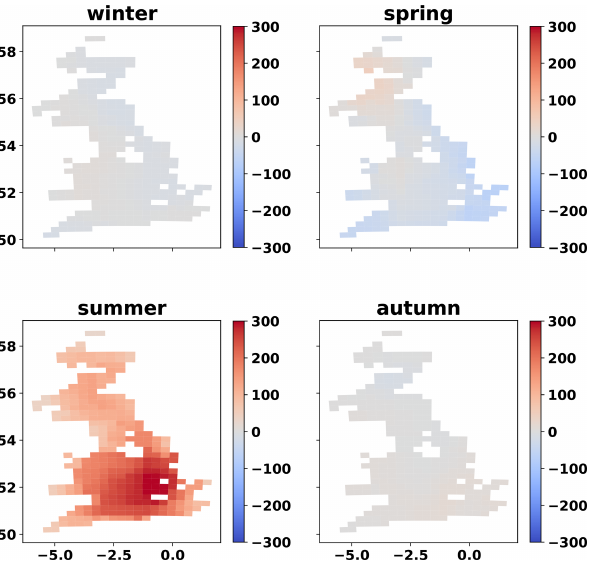
Figure A7. Map of inter-annual (2017–2018) difference in 3-week average VPD (Pa) per season. The map is a 25km grid of GB. Only grid cells that contain at least one simulated field are